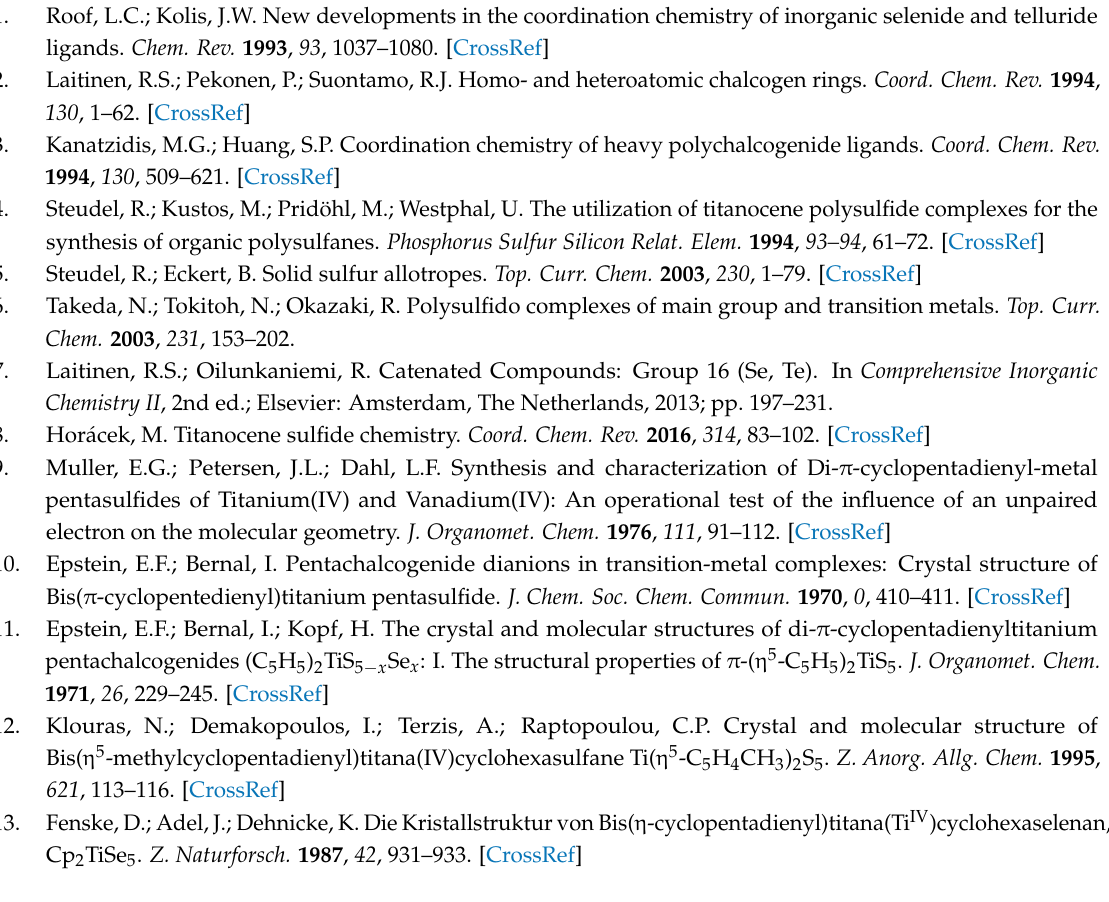
Supplementary Materials: The following are available online, Table S1. The site occupancy factors of selenium in the disordered chalcogen atom sites of the crystals of phases B – E ; Table S2. The interatomic chalcogen-chalcogen and chalcogen-titanium distances; Table S3. The composition of the solid solution of phases B – E based on the site occupancy factors of selenium in different chalcogen atom positions; Table S4. Energy terms of atoms (in a.u.) used in the DLPNO-CCSD(T)/CBS enthalpy of formation calculations; Table S5. Energy terms of atoms (in Hartree) used in the DLPNO-CCSD(T)/CBS enthalpy of formation calculations; Table S6. The DLPNO-CCSD(T)/CBS formation enthalpies (298 K) of TiCp 2 Se x S 5 − x molecules calculated at non-relativistic ∆ f H nonrel. . And relativistic level ∆ f H with core-correlation and scalar relativistic [ ∆ E (C + R)] and spin-orbit [[ ∆ E (SO)] energy corrections included; Table S7. Isotropic 77 Se NMR shielding values calculated at PBE0/def2-TZVPP level of